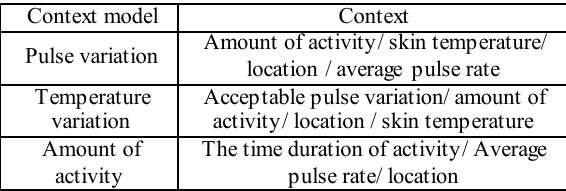
Table 1. The context models of an emergency